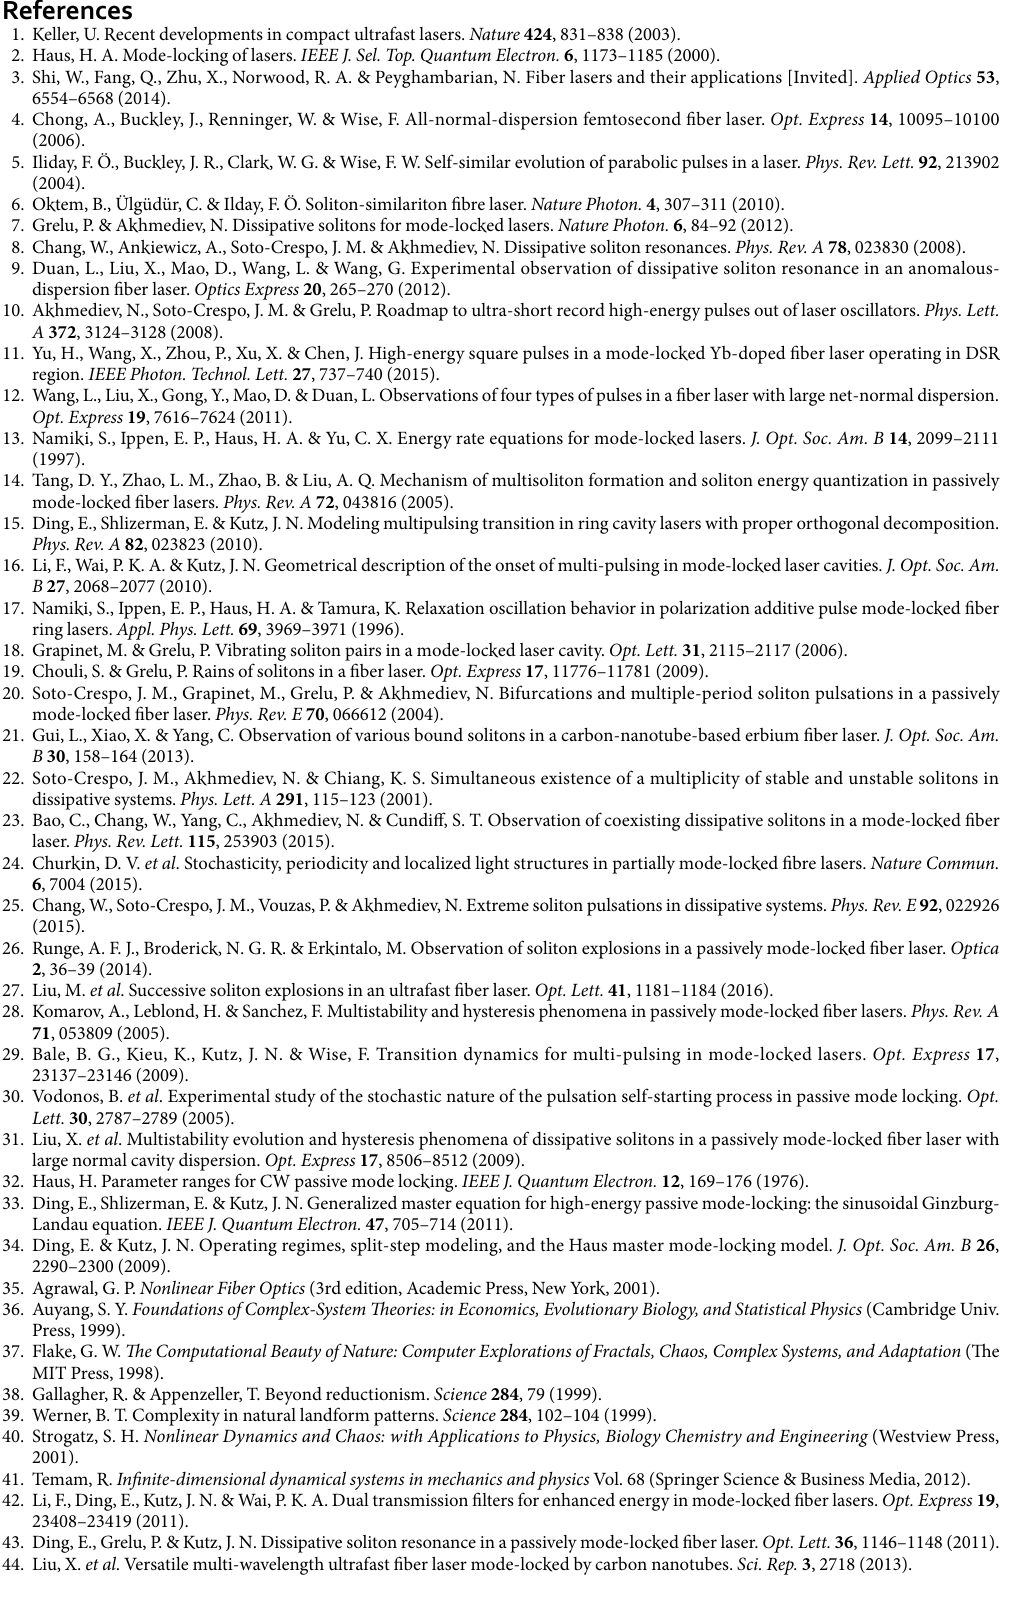
For Fig. 6(e,f) g 0 = 2.5; For Fig. 6(g,h) g 0 = 3.0. The parameters for Fig. 7: